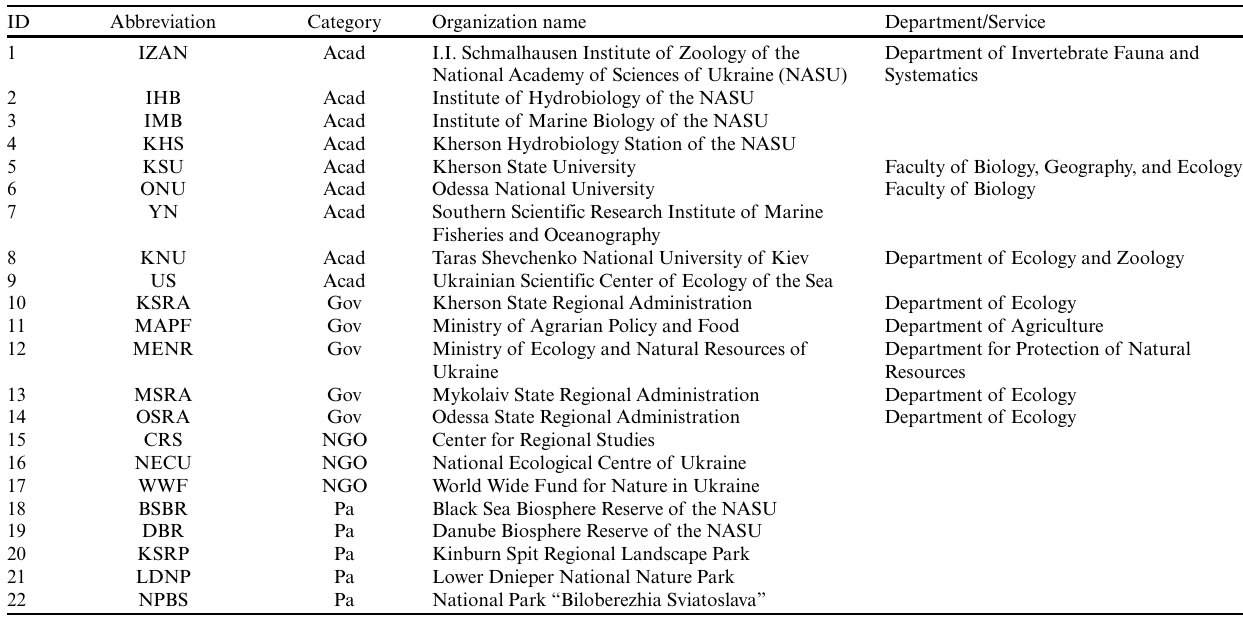
Table 1 . Stakeholders included in the study, and their respective stakeholder categories. “Acad” – academic institutions, “Gov” – governmental, “NGO” – nongovernmental, and “Pa” – protected